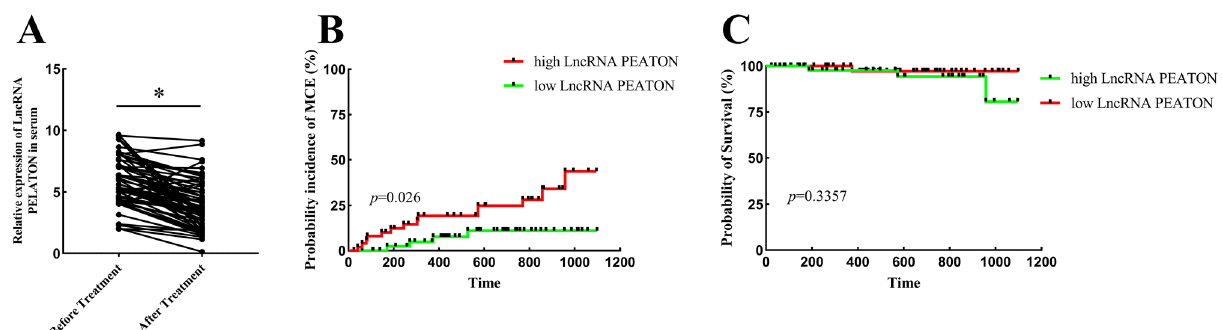
Figure 5. Survival analysis of ACS individuals. ( A ) The expression of lncRNA PELATON in patients with treatment. ( B ) The incidence of MCE in ACS patients between high and low lncRNA PELATON expression. ( C ) The probability of survival between high and low lncRNA